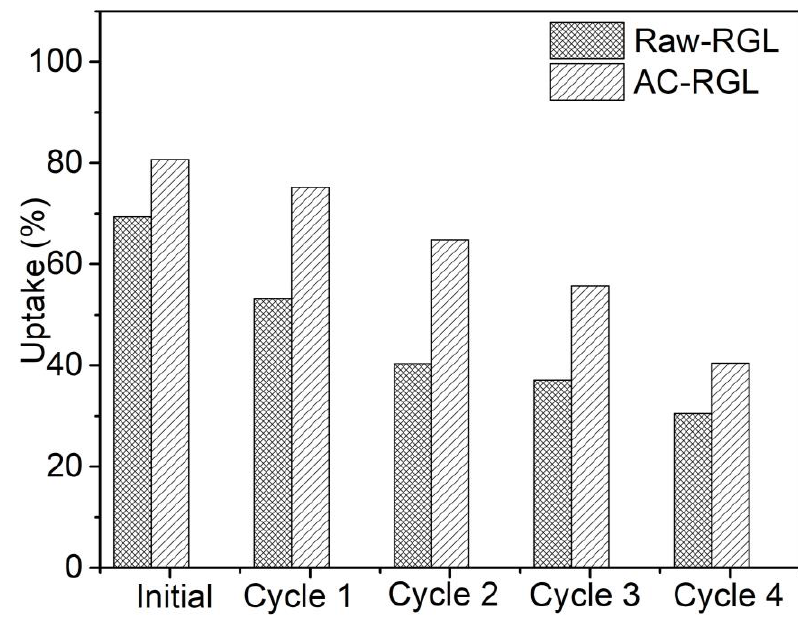
Figure 11. Reusability test of Raw-RGL and AC-RGL adsorbents.